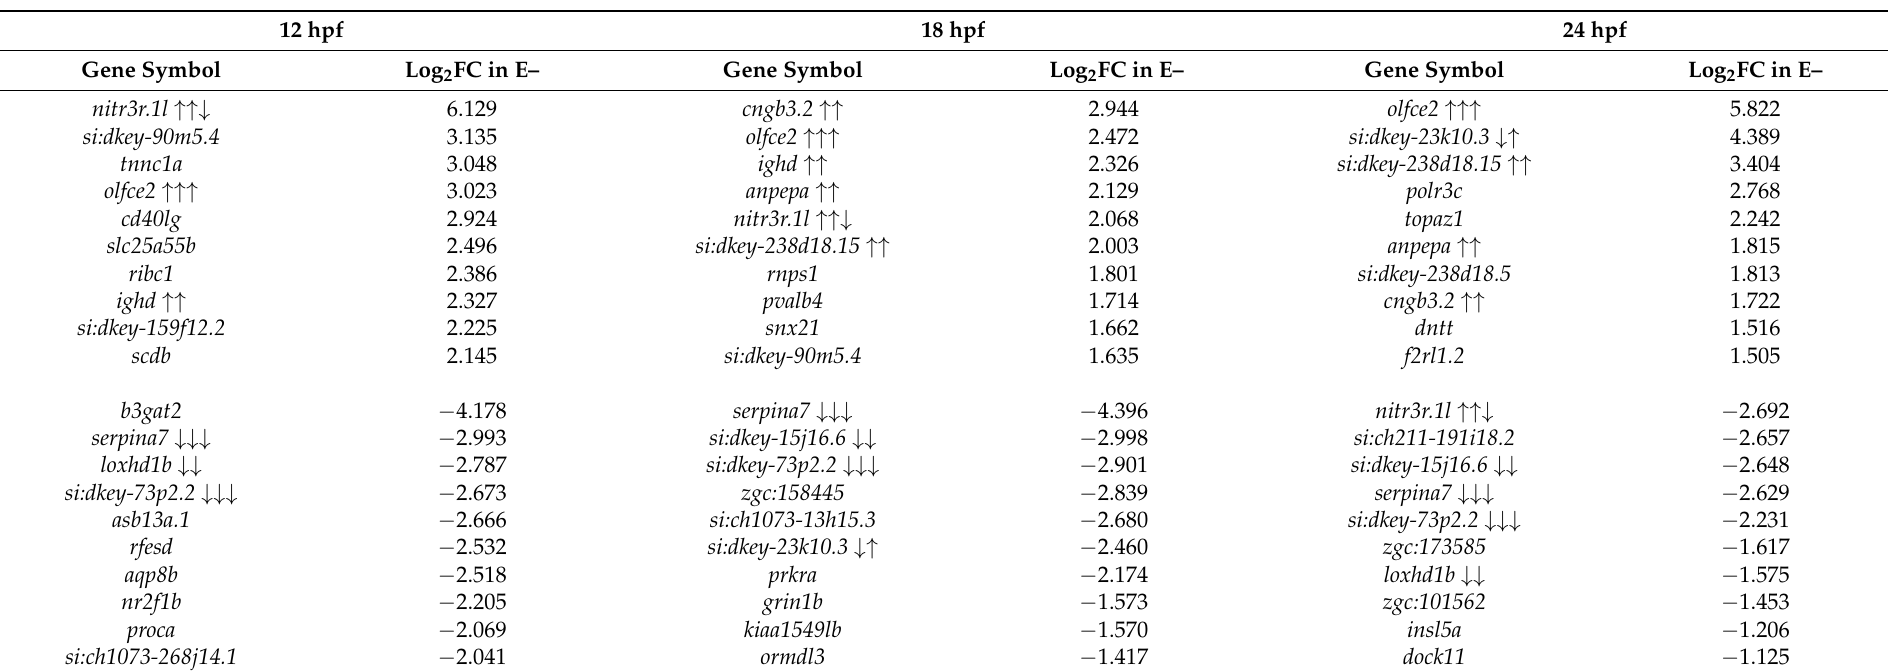
Table 1. Top differentially expressed genes in E– embryos relative to E+ at 12, 18 and 24 hpf. Top 10 DE genes by absolute value log 2 FC at each time point with log 2 FC in E– embryos relative to E+. ↑ and ↓ indicate a DE gene found in the top 10 consistently increased or decreased in E– embryos at each age (12, 18, 24 hpf). 12